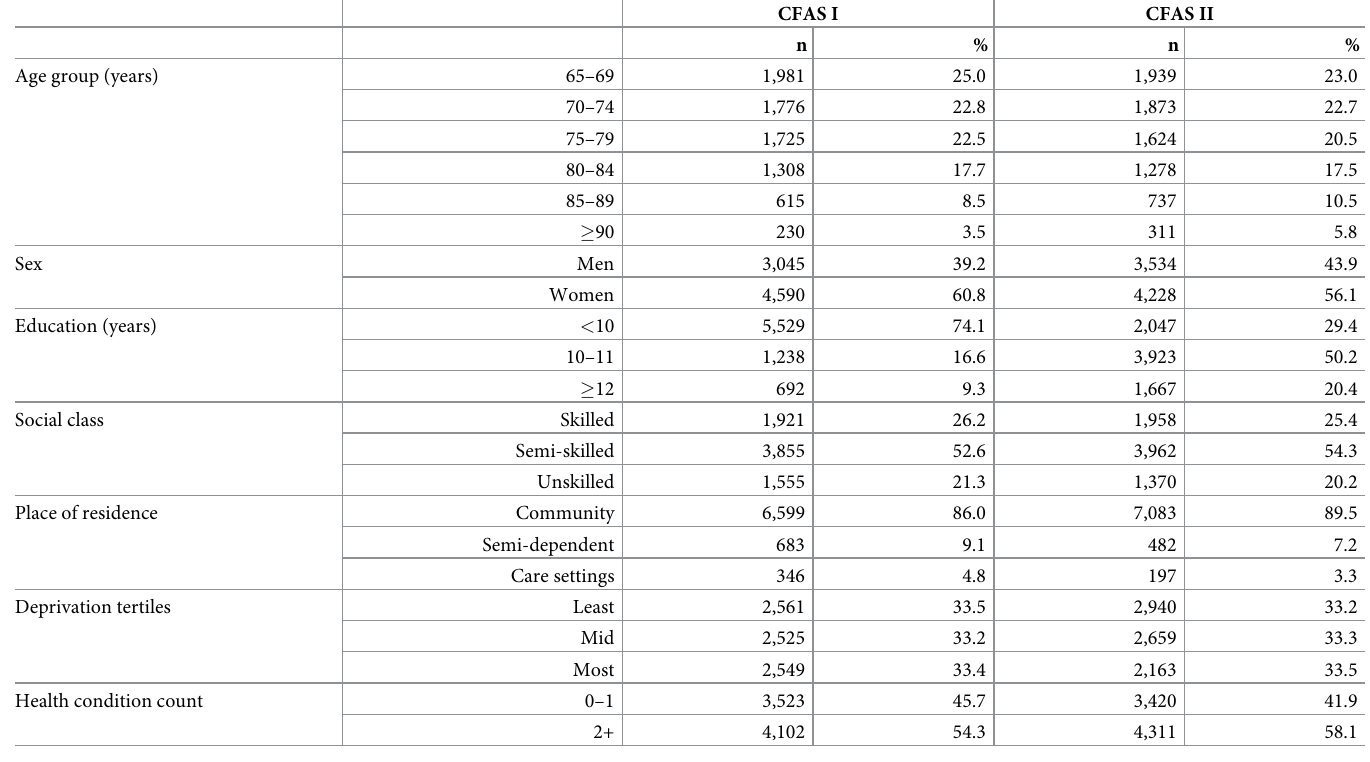
Table 1. Number and weighted percentage of demographics at baseline in the CFAS I and CFAS